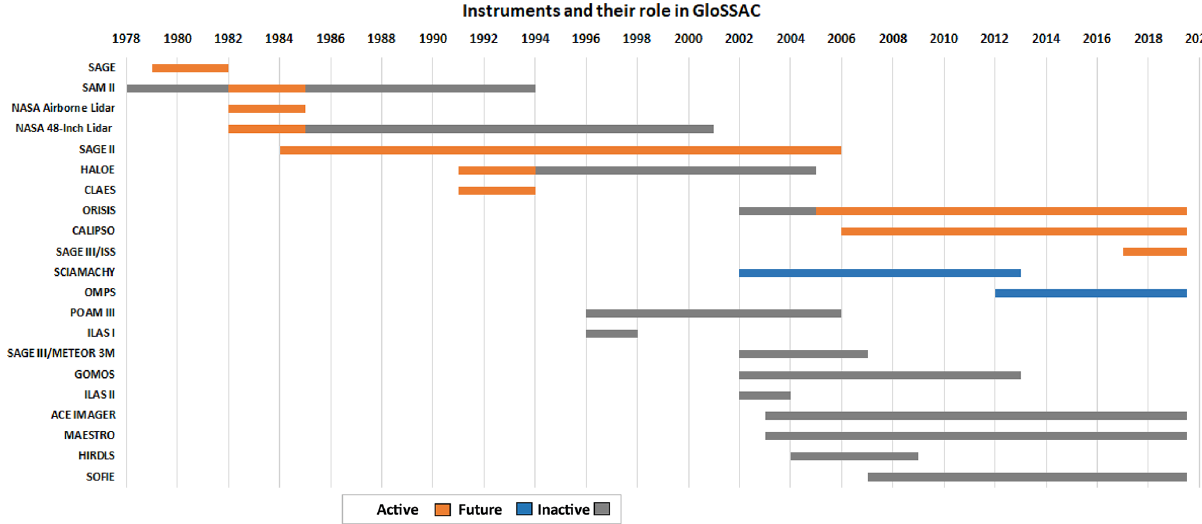
Figure 1. Space-based measurements of stratospheric aerosol extinction coefficient data used in